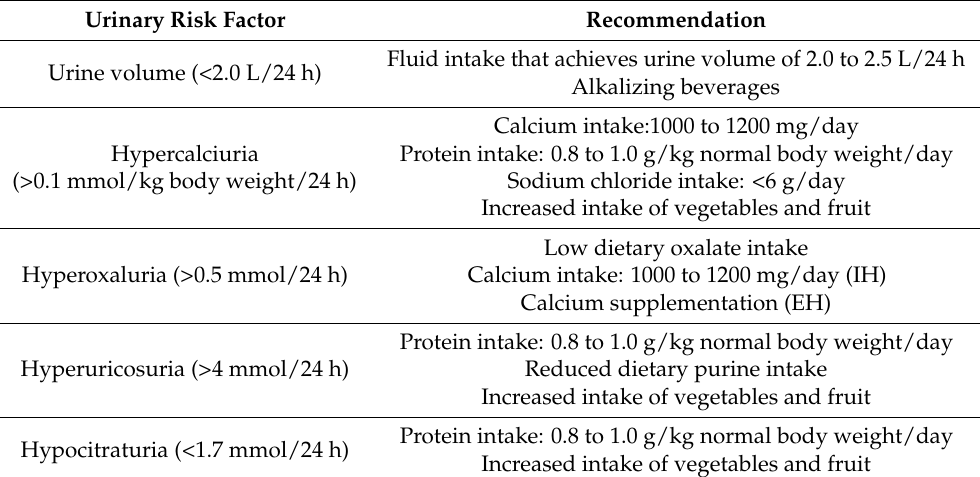
Table 1. Dietary recommendations for patients with calcium oxalate stones